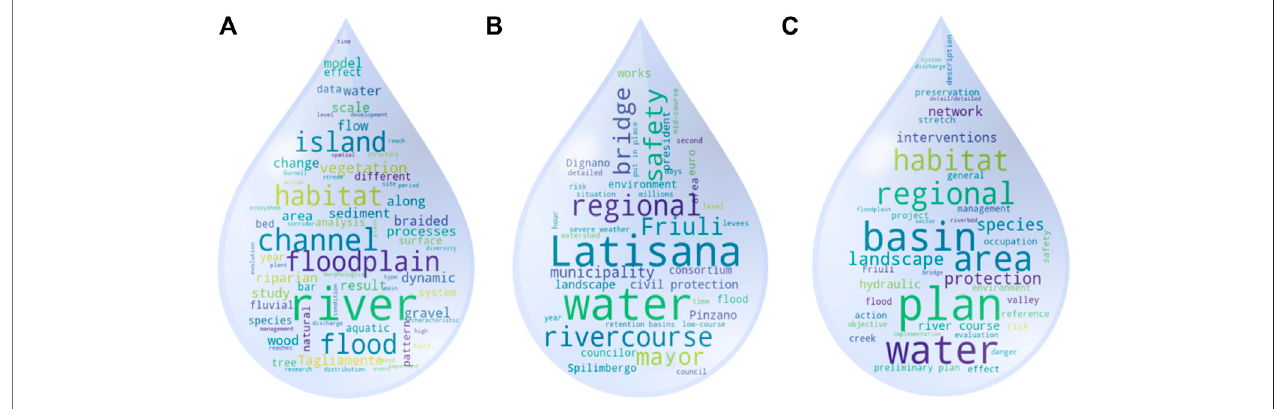
FIGURE 2 | Word clouds showing the most frequent words in the fi ltered academic literature (A) , fi ltered newspapers articles (B) , and local regulatory documents (C) . All keywords are shown in English (translated).